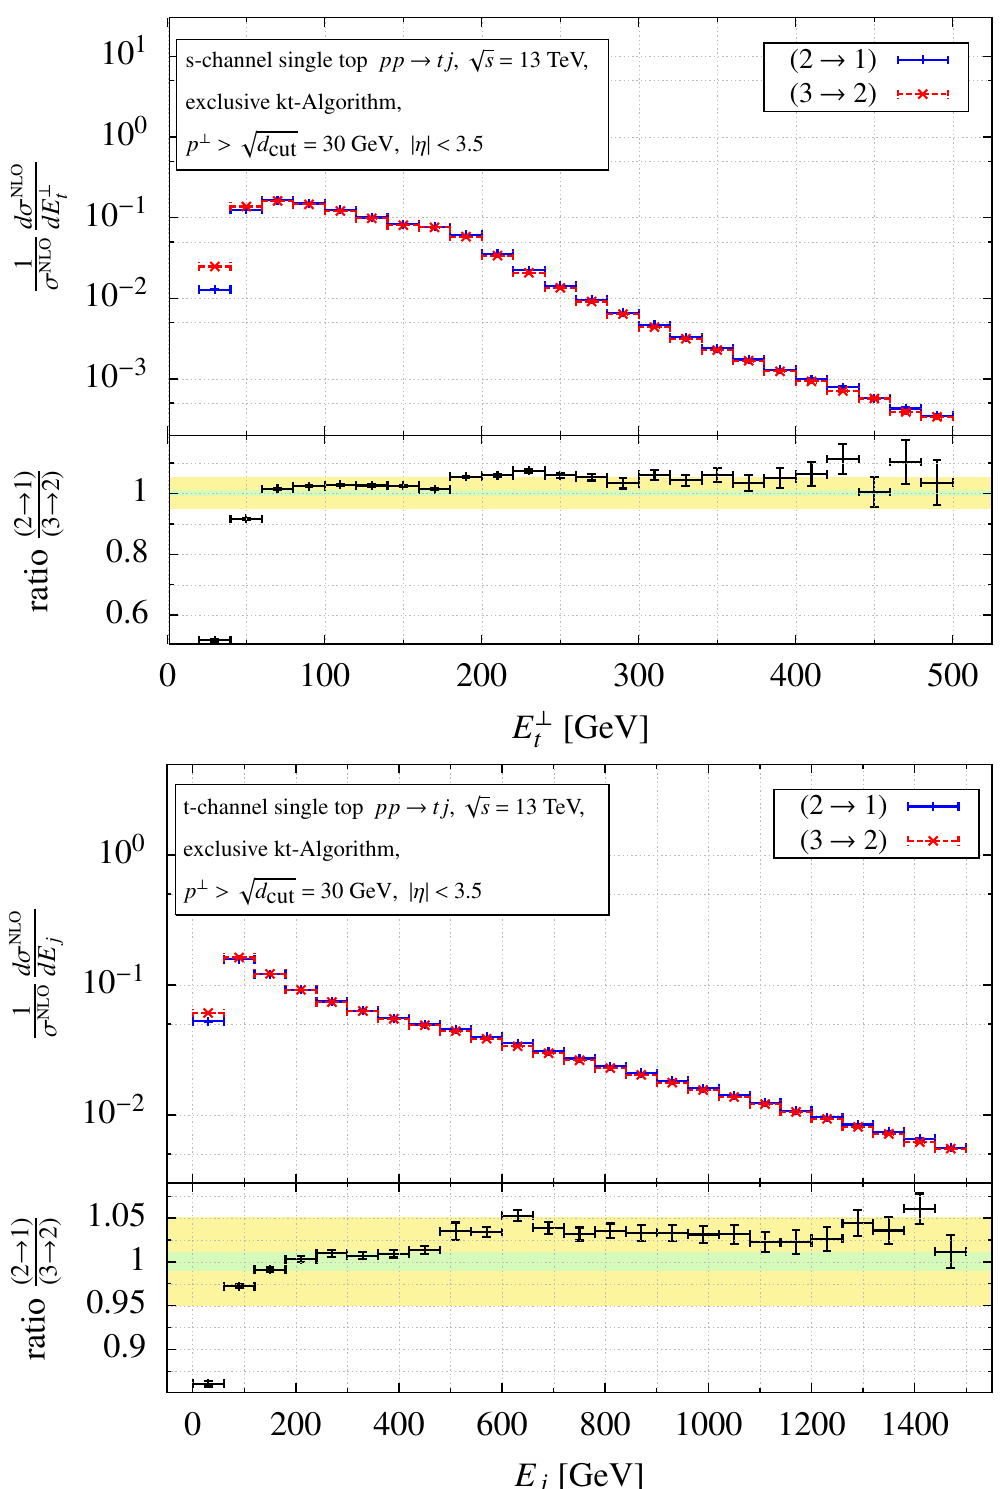
Figure 23 . (Transverse) Energy distributions of the top-tagged and light jet from s - and t -channel single top-quark production at NLO with 3 ! 2 (red, dashed) and 2 ! 1 (blue, solid) jet clusterings.